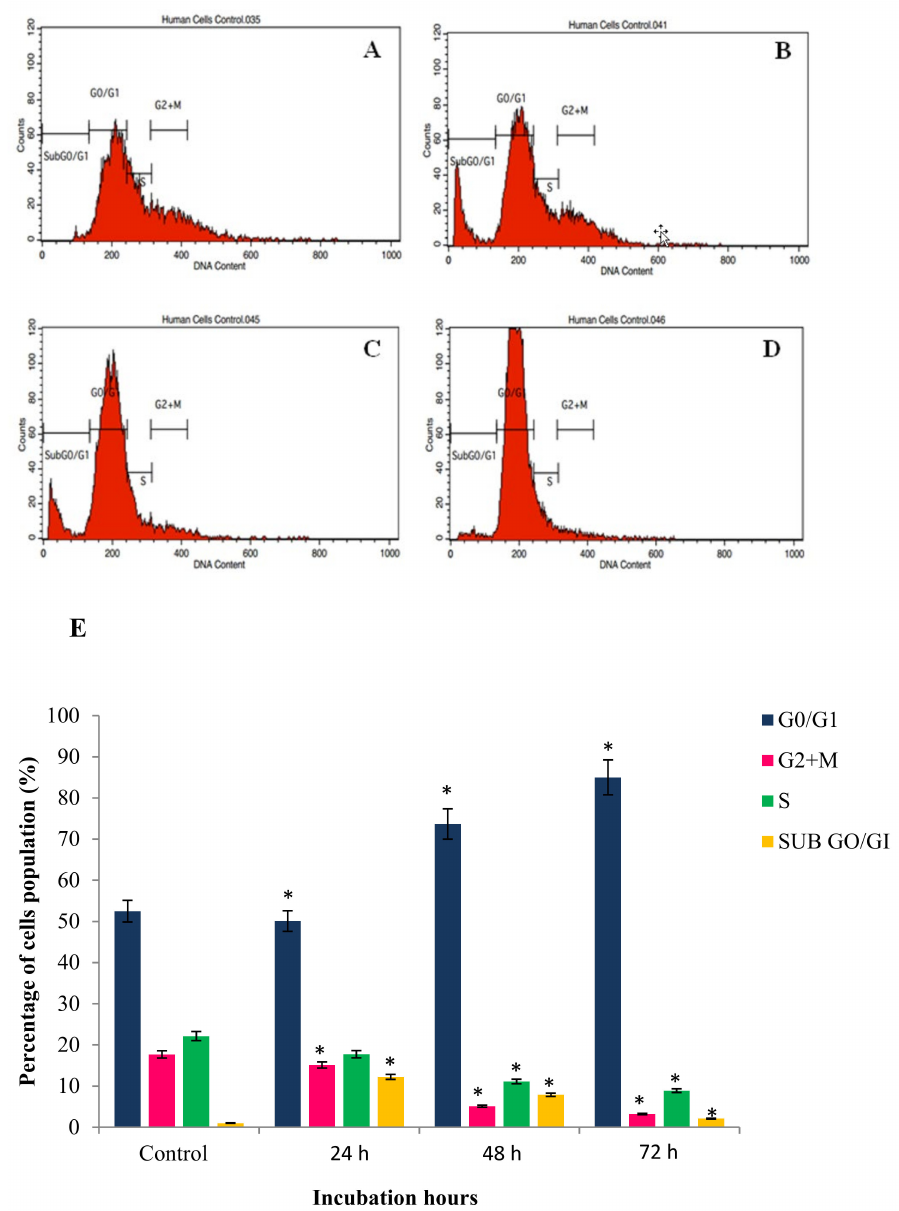
Figure 6. Cell cycle arrest histogram of GNST-ITC-treated HepG2 cells at 7.83 µ M in a time-dependent manner by flow cytometry: ( A – D ) control and 24 h, 48 h, and 72 h treated cells respectively. ( E ) Bar chart shows percentage of cells distribution after the treatment. Values are presented as means ± SD of triplicate experiments. Significant di ff erence ( p < 0.05) as compared to control is indicated by